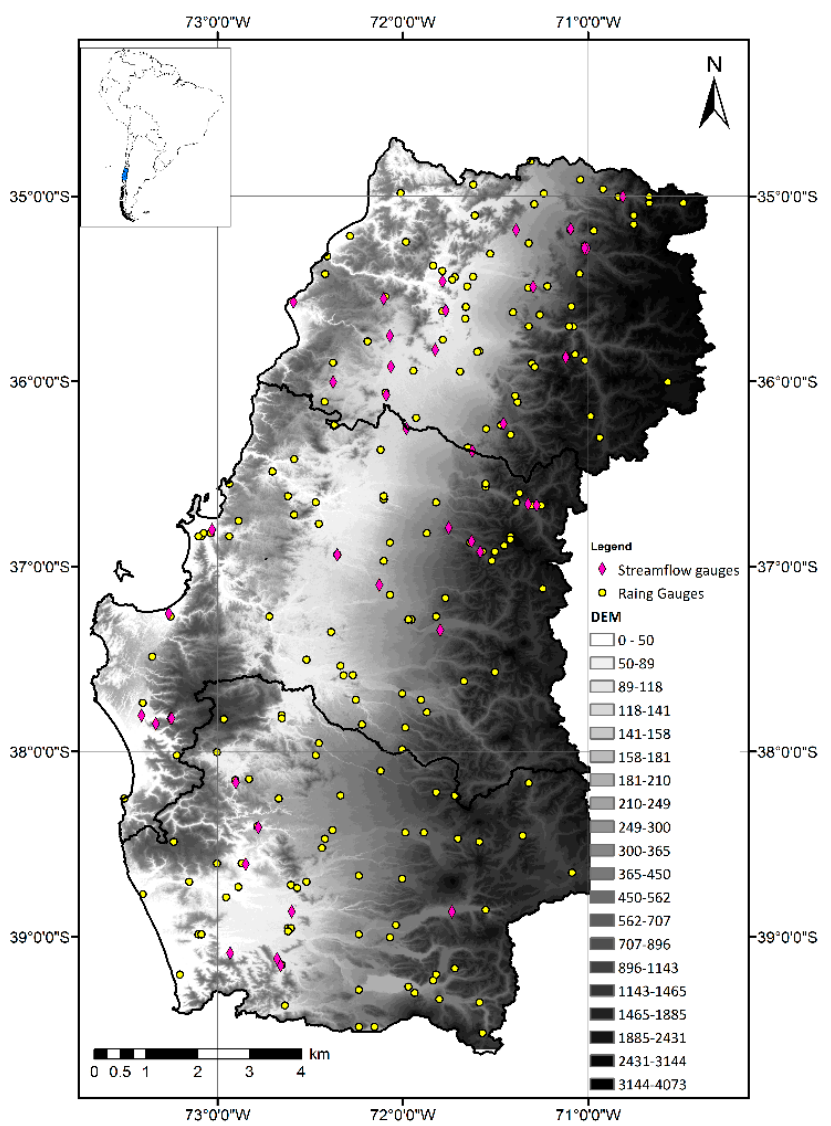
Figure 1. Study area, with locations of precipitation gauge stations (circles) and streamflow gauging stations (rhombuses). Made by the authors.